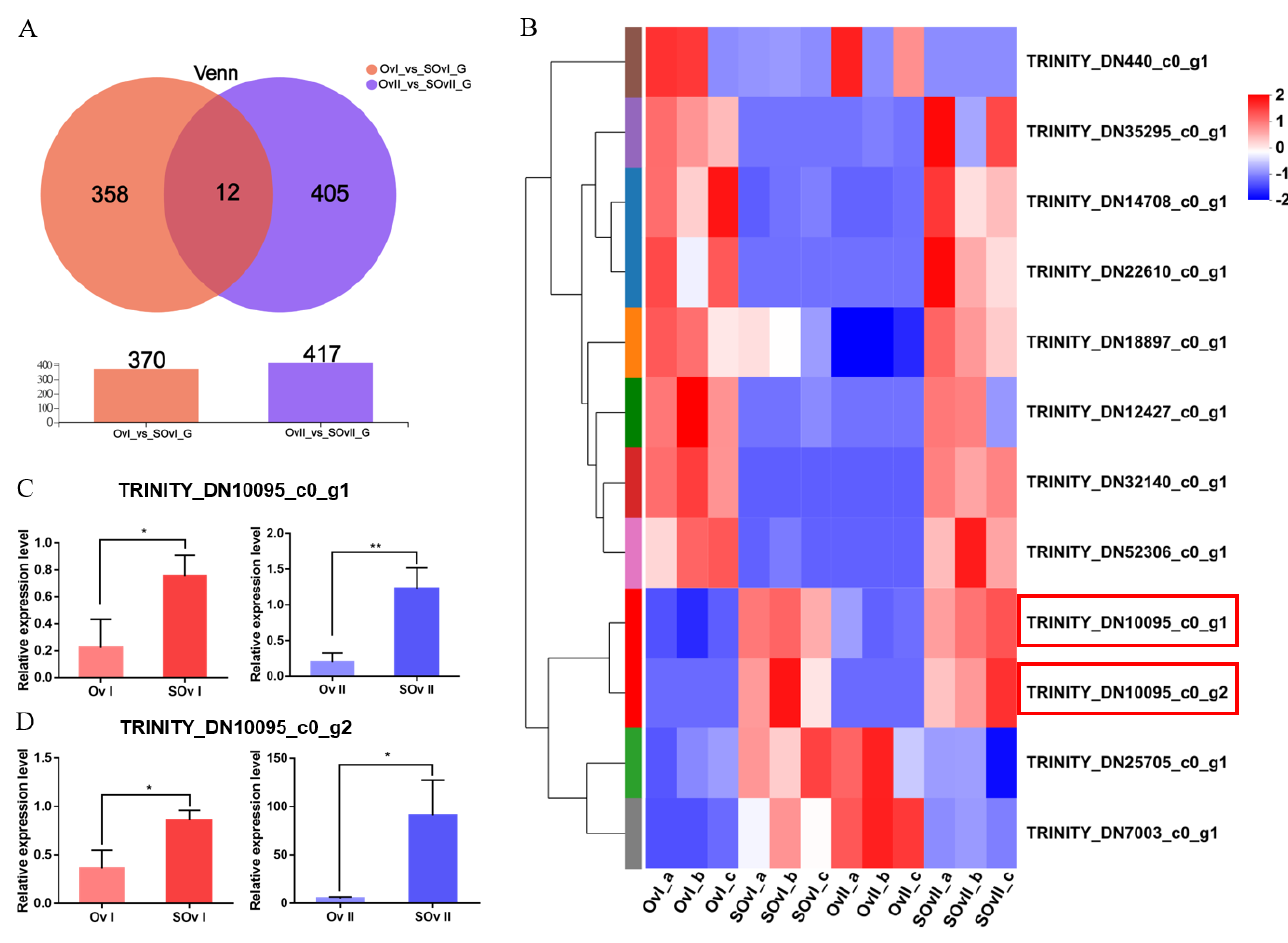
Figure 5. DEGs in the ovary. ( A ) Venn diagram of DEGs at 1 and 6 days after eyestalk ablation in E. carinicauda . ( B ) Heatmap of the 12 overlapping genes. ( C ) Validation of TRINITY_DN10095_c0_g1 and ( D ) TRINITY_DN10095_c0_g2 expression levels by real-time PCR at different timepoints (* p < 0.05, ** p < 0.01).